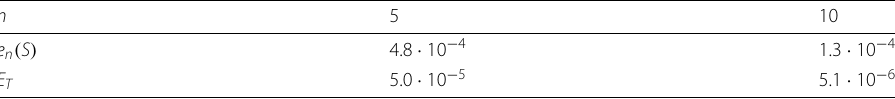
Table 7 Errors e n and E T with the S spline for